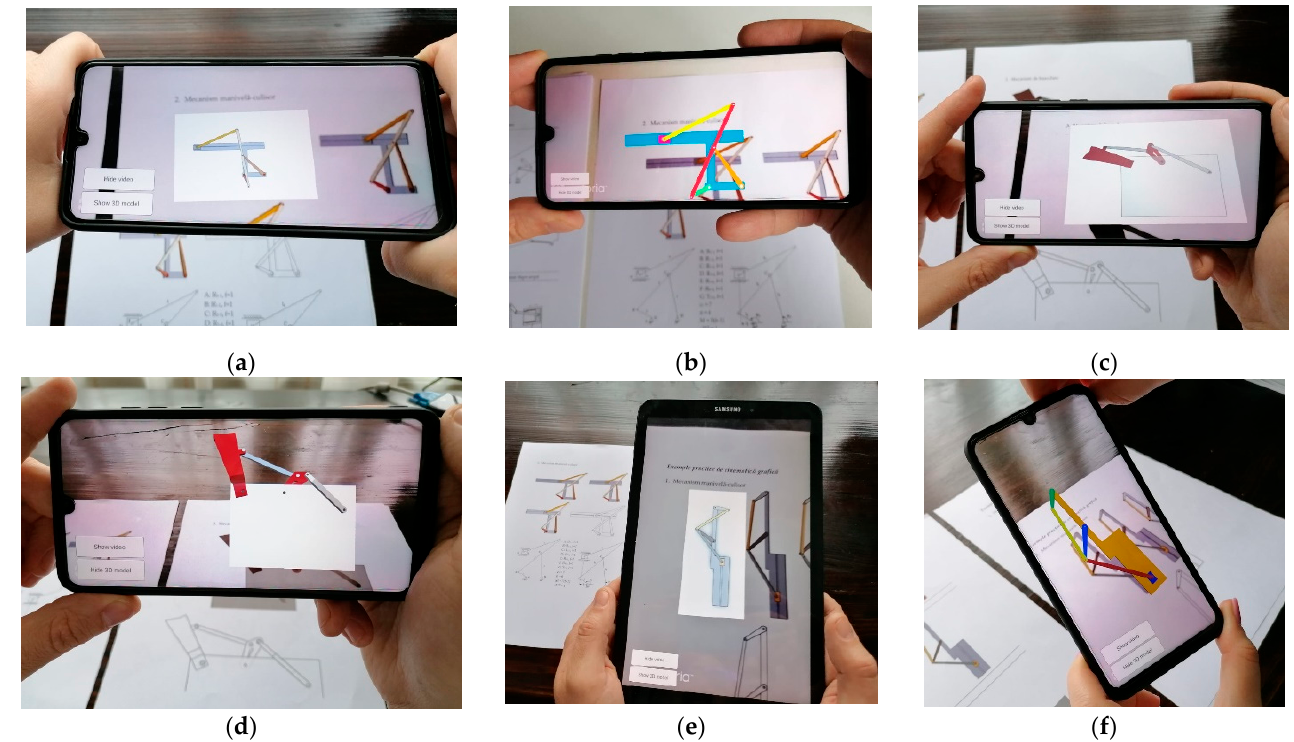
Figure 7. “AR Mecs” application functions: crank-slider mechanism 1: ( a ) video, ( b ) 3D model; crank-slider mechanism 2: ( c ) video, ( d ) 3D model; tilting mechanism: ( e ) video, ( f ) 3D model.